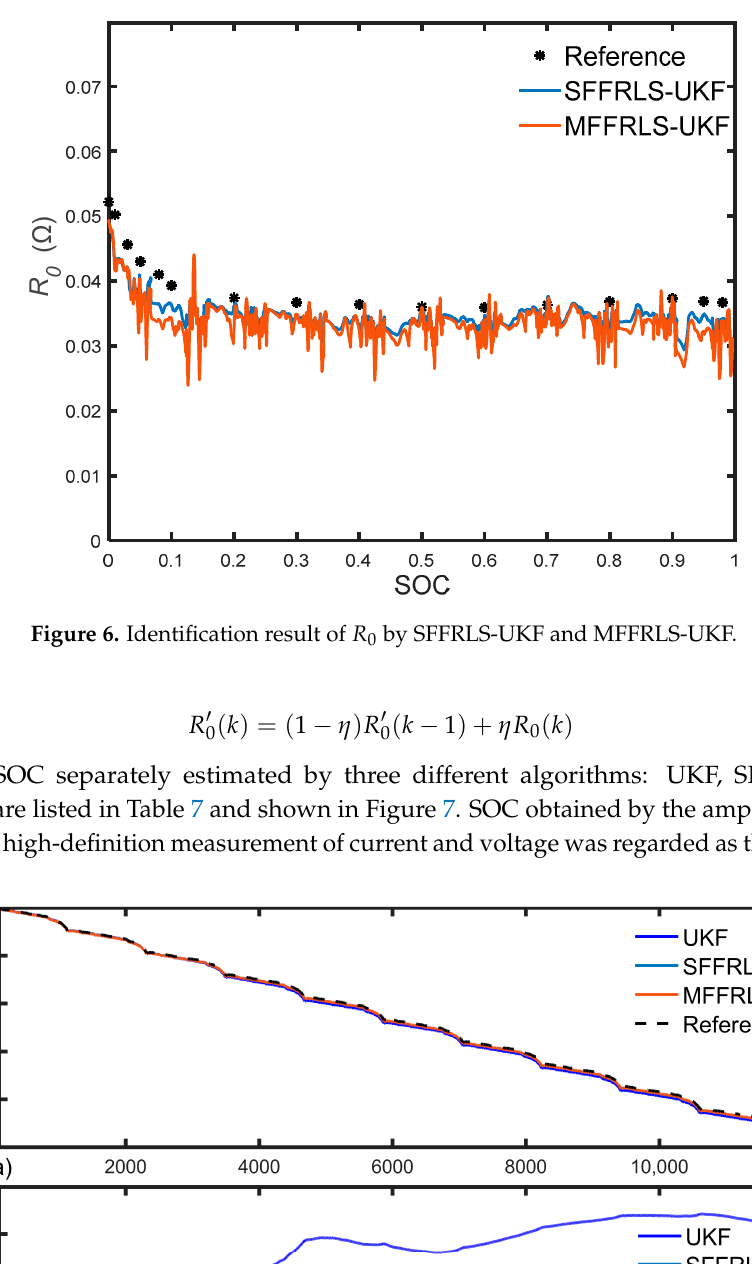
Figure 7. SOC estimation result of UKF, SFFRLS-UKF and MFFRLS-UKF during NEDC test under 25 °C constant temperature: ( a ) SOC estimation; ( b ) SOC estimation error. Table 7. Statistic characters of SOC estimation of constant temperature NEDC test.